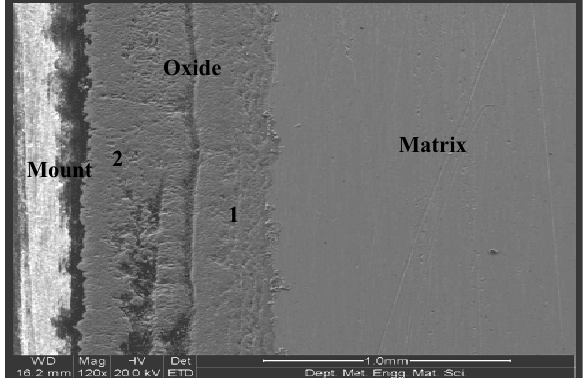
Figure 6. SEM Micrograph of the cross section of P92 al- loy oxidized in air at 1073 for 1000 h.